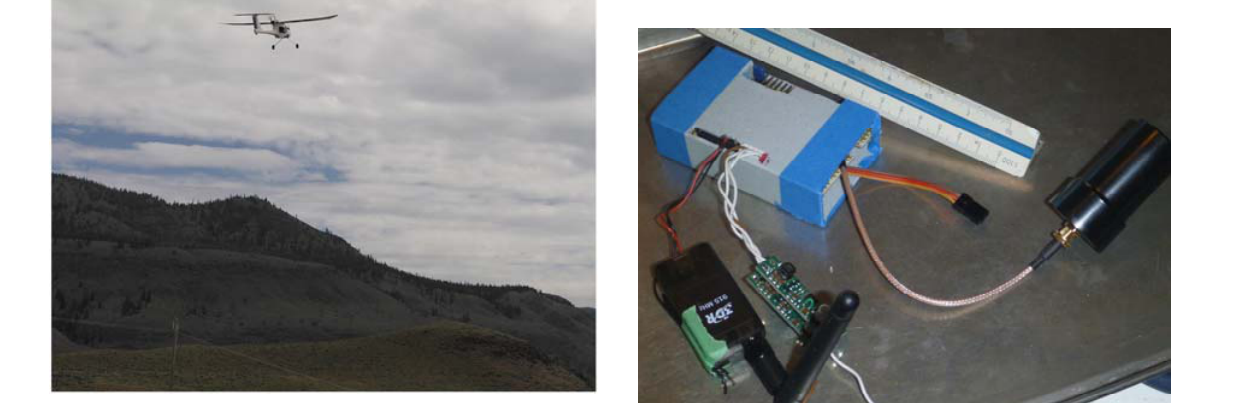
Figure 7. Study UAV during autonomous flight